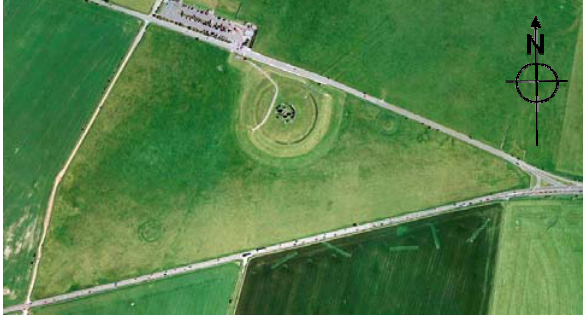
Figure 2 Extent of survey within ‘The Triangle’ (Image supplied through Pan Government Agreement) However as the landscape, stone circle and individual stone